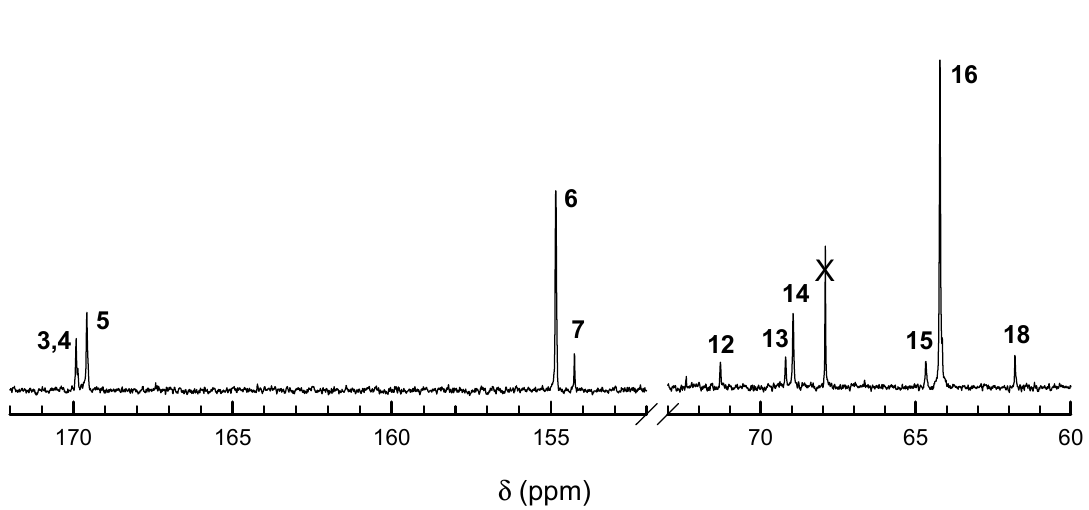
Figure 4. 13 C NMR spectra of Tmc / Lac copolymers prepared with R - Ini . Polymerization conditions: [ Lac ] 0 , [ Tmc ] 0 , [ R - Ini ] 0 = 1.2, 2, and 2 × 10 − 3 (+[ i PrOH] 0 = 4 × 10 − 3 ) mol·L − 1 , respectively. Time 3.81 × 10 6 s, conversion Lac = 92%, conversion Tmc = 99%. Note large contributions of signals of homo Lac and Tmc sequences, signals 13, and 15, respectively. Assignment of signals is given in Table 1.